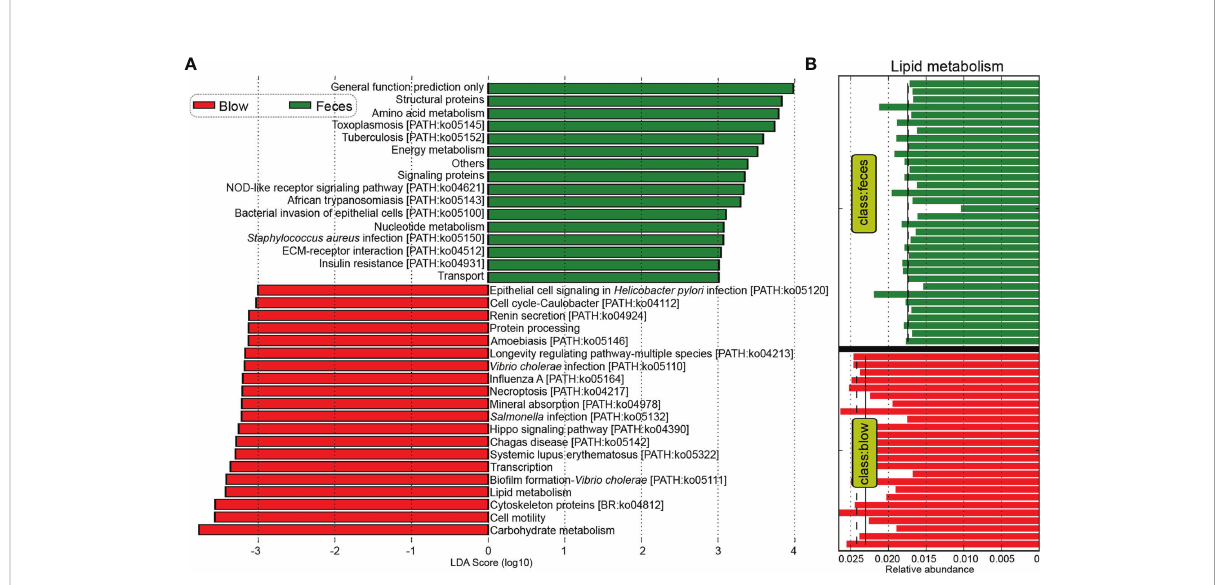
FIGURE 5 Comparative analyses of potential functions between the blow and fecal microbiomes. (A) , Kyoto Encyclopedia of Genes and Genomes (KEGG) pathways enriched in the blowhole and fecal microbiomes by the Linear discriminant analysis Effect Size (LEfSe) analysis. (B) , the lipid metabolism pathway was signi fi cantly higher in the blow than in the fecal microbiome. The mean and median relative abundance are indicated with solid and dashed lines, respectively.